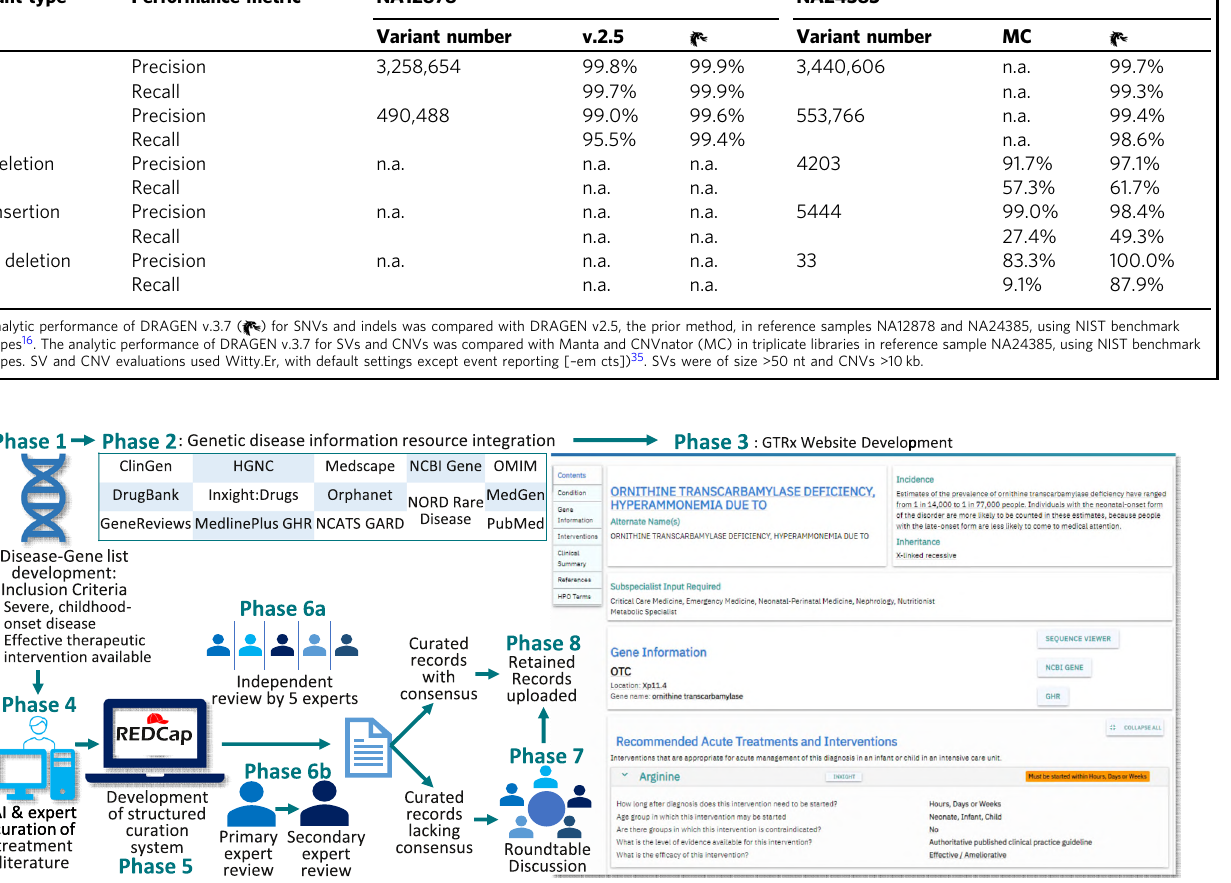
Table 2 Comparison of the analytic performance of standard, clinical rWGS, and the 13.5-h method. Variant type